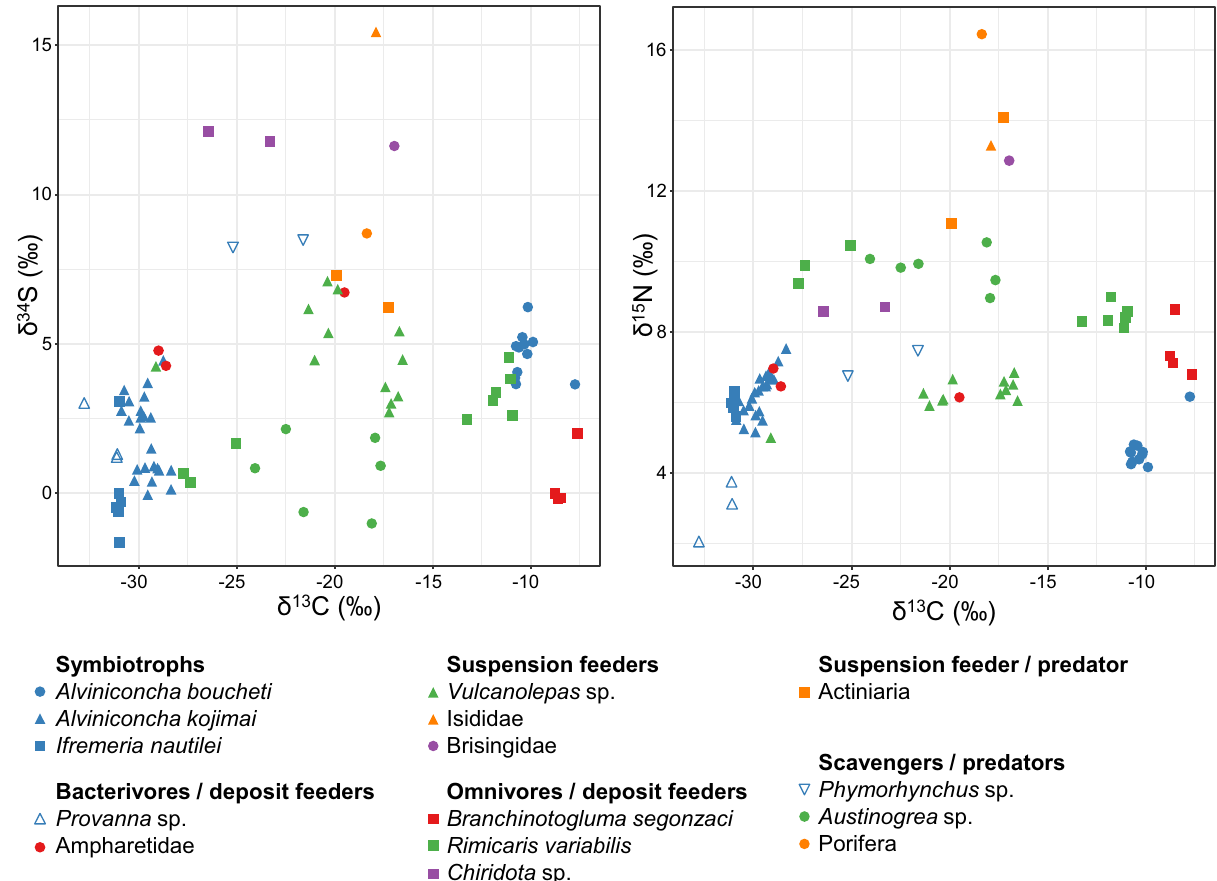
Fig. 6 Stable isotope food web diagram of LSVF animal communities. Stable isotope ratios of carbon vs. sulfur (left) and carbon vs. nitrogen (right) in benthic fauna from La Scala, Woodlark Basin. Blue: molluscs, red: polychaetes, green: crustaceans, orange: sponges and cnidarians, purple: echinoderms. Organisms have been assigned to functional feeding guilds according to literature